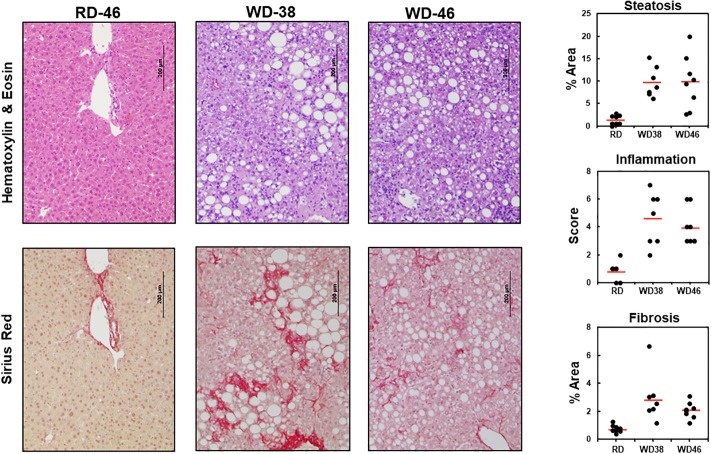
Western diet effects on hepatic morphology.Livers of mice in the 3 groups, RD46, WD38 & WD46, were fixed in buffered formalin, sectioned and stained with hematoxylin and eosin and Sirius red. Images were photographed at 100x; the magnification bar (200 μm) is included on the image. Sections shown are representative of the average (red horizontal line) value for fibrosis in each group. Livers in each group were scored for the level of steatosis, inflammation and fibrosis as described in Materials & Methods and [35]. Data is represented as a scatter plot to illustrate the heterogeneity within each group. Steatosis and Fibrosis are represented as the % Area occupied by lipid droplets and fibrosis, respectively. Inflammation is represented by a score; the scoring scale is: normal (<0.5), slight (0.5–1.0), moderate (1–2), severe (>2). The red horizontal bar represents the average of all animals within each group. Additional histology slides representing micro- and macro-steatosis, inflammation (S1 Fig) and fibrosis (S2 Fig) are included in the Supplement.